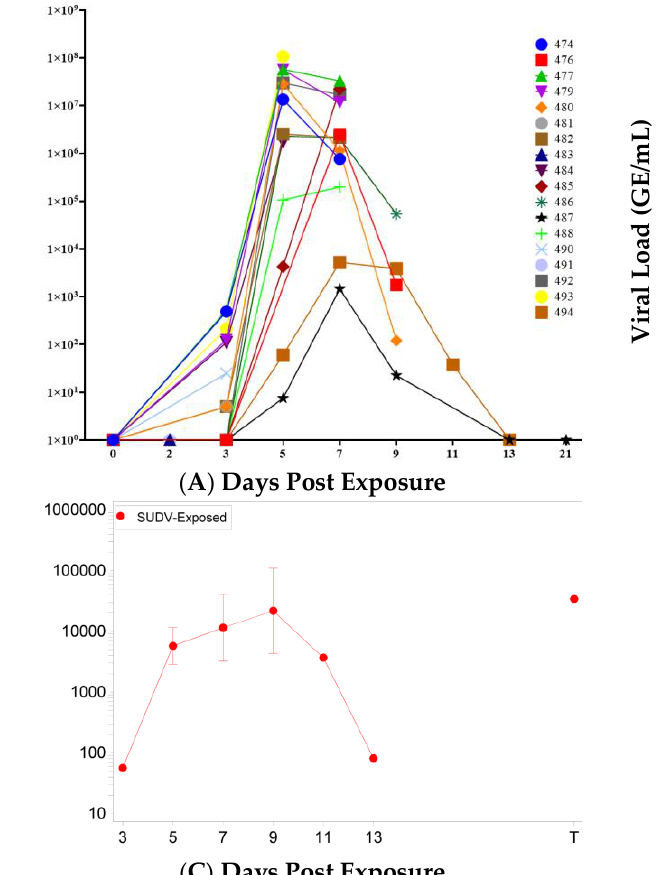
Figure 5. Viral Load. ( A ) PFU/mL. ( B ) GE/mL. ( C ) sGP; mean with 95 percent confidence intervals (confidence interval was not plotted for sample size less than 3), values were log-transformed and the geometric mean is displayed; T represents Terminal (data collected from animals that met euthanasia criteria were combined and reported as a single terminal time